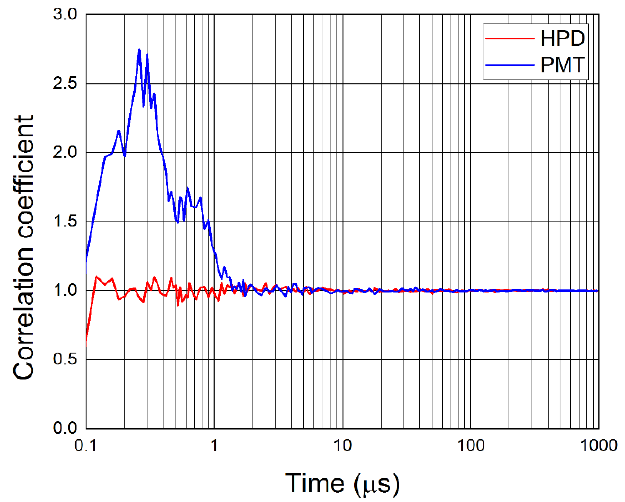
Figure 7. Afterpulse noise of PMT and HPD [32]. The data were obtained through detection of single photons from a continuous wave (CW) light source (wavelength = 470 nm). The cathode supply voltage and the reverse voltage of HPD were − 8 kV and 398 V, respectively.